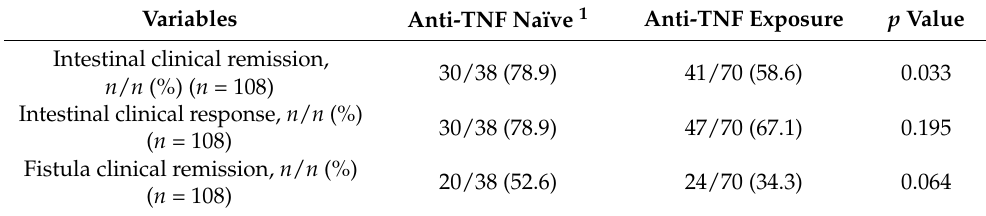
Table 3. Efficacy of UST on patients with anti-TNF exposure and anti-TNF